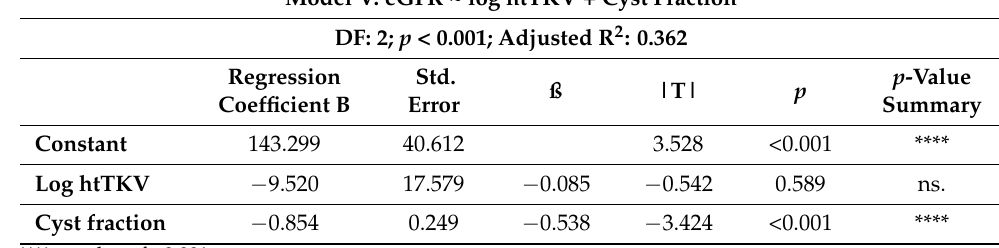
Table 3. Multivariate linear regression of the subcohort year 1 ( n = 98). eGFR served as the dependent variable, while the cyst fraction and log htTKV acted as the independent variables. eGFR, estimated glomerular filtration rate; DF, degrees of freedom; htTKV, height-adjusted total kidney volume; ns, not significant.